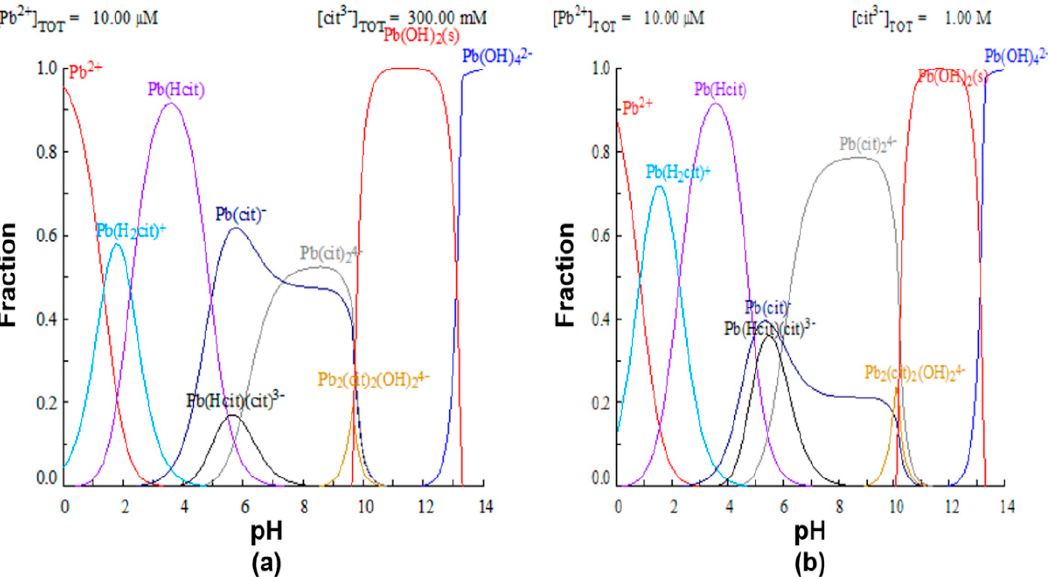
Figure 6. Species distribution diagram of lead with different concentrations of citrate ion. ( a ) 0.3 M and ( b ) 1.0 M.